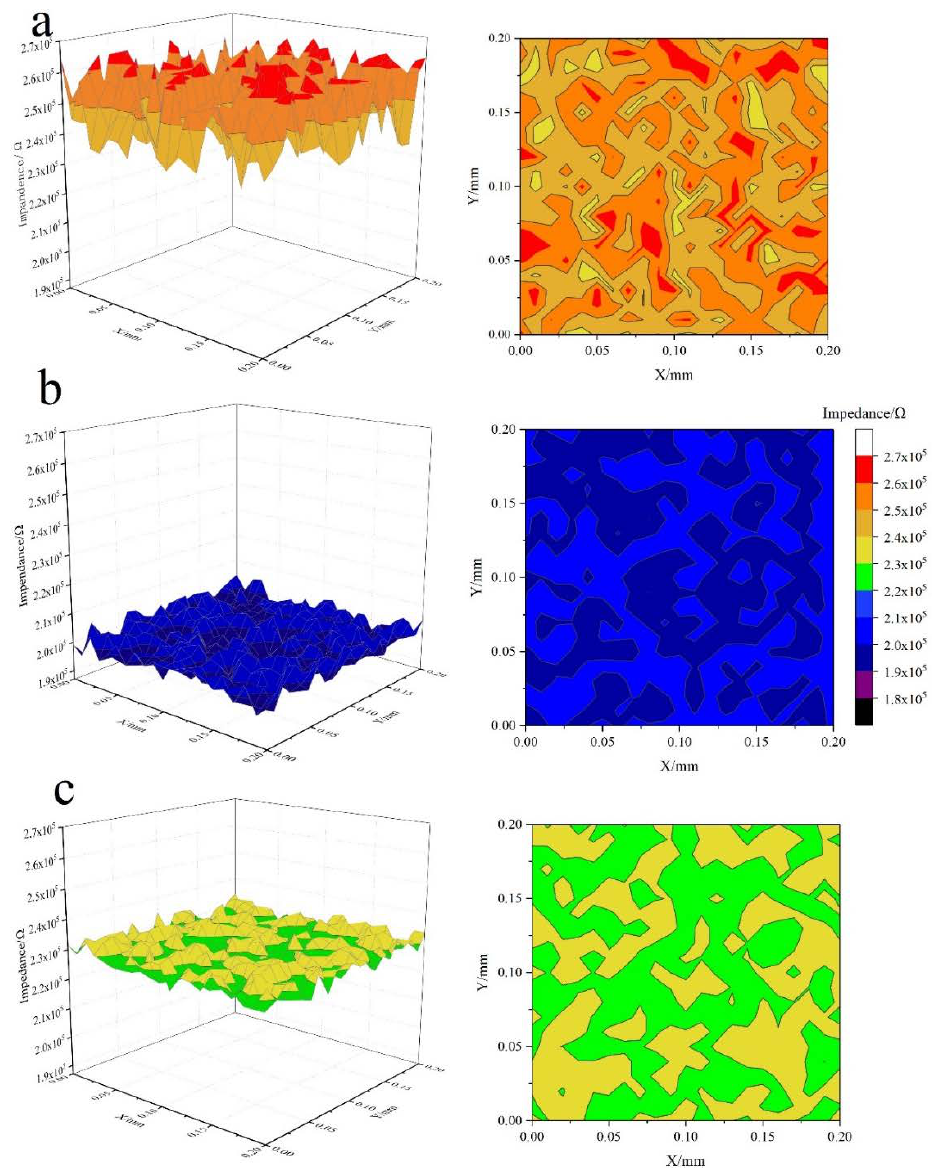
Figure 3. LEIS maps of hemimorphite surfaces treated with ( a ) deionized water, ( b ) 5 mM Na 2 S, and ( c ) 5 mM Na 2 S and 1mM Fe 3+ .